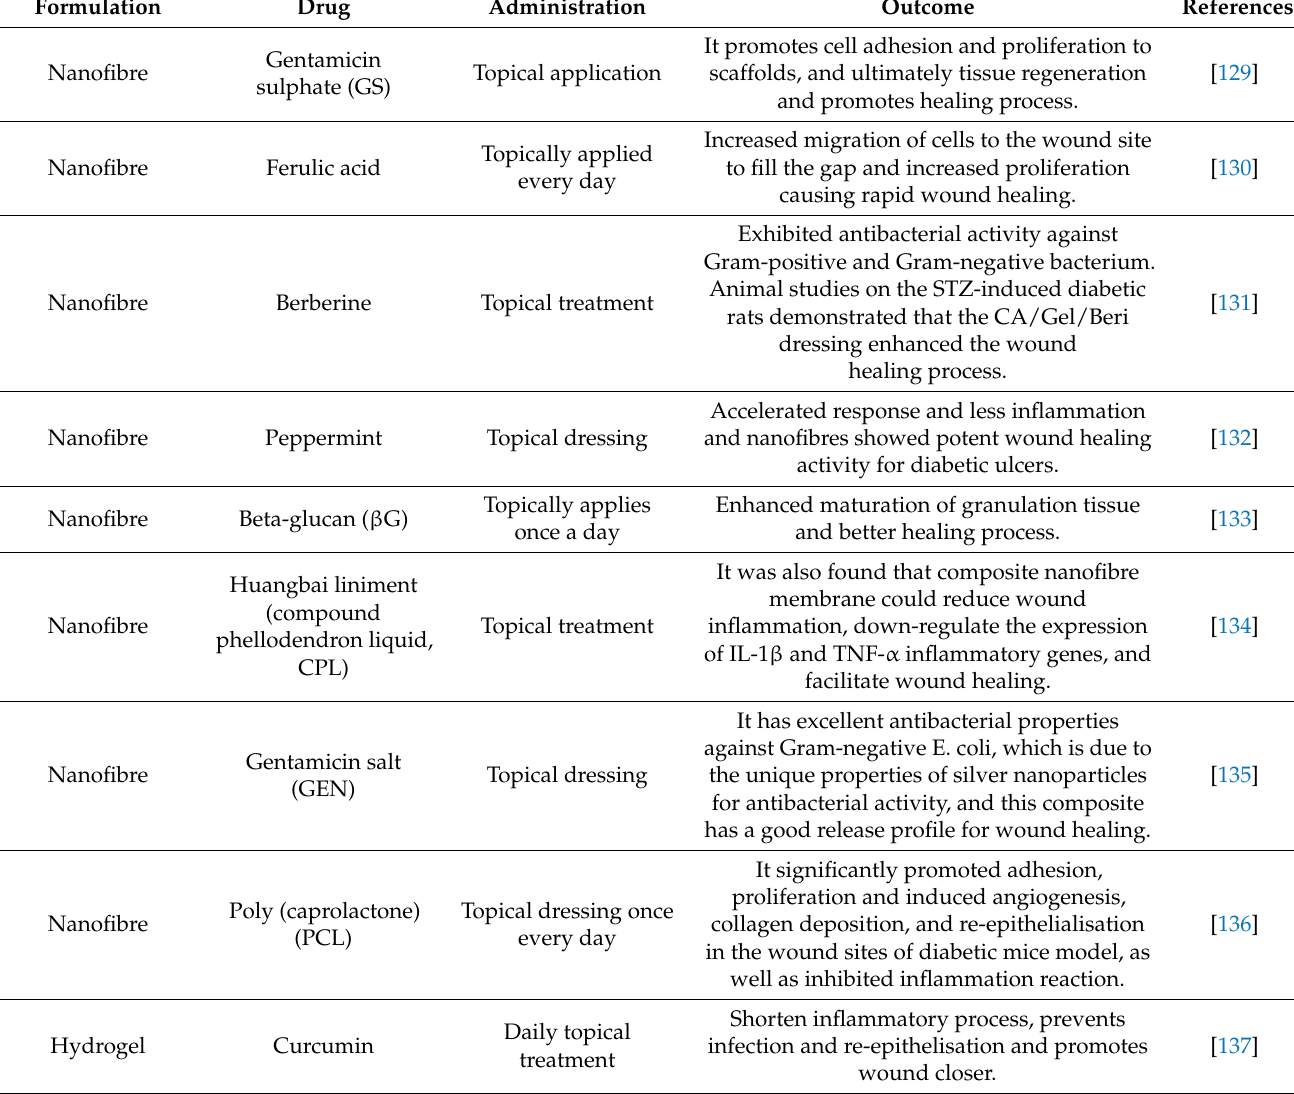
Table 2. Localised delivery systems of several